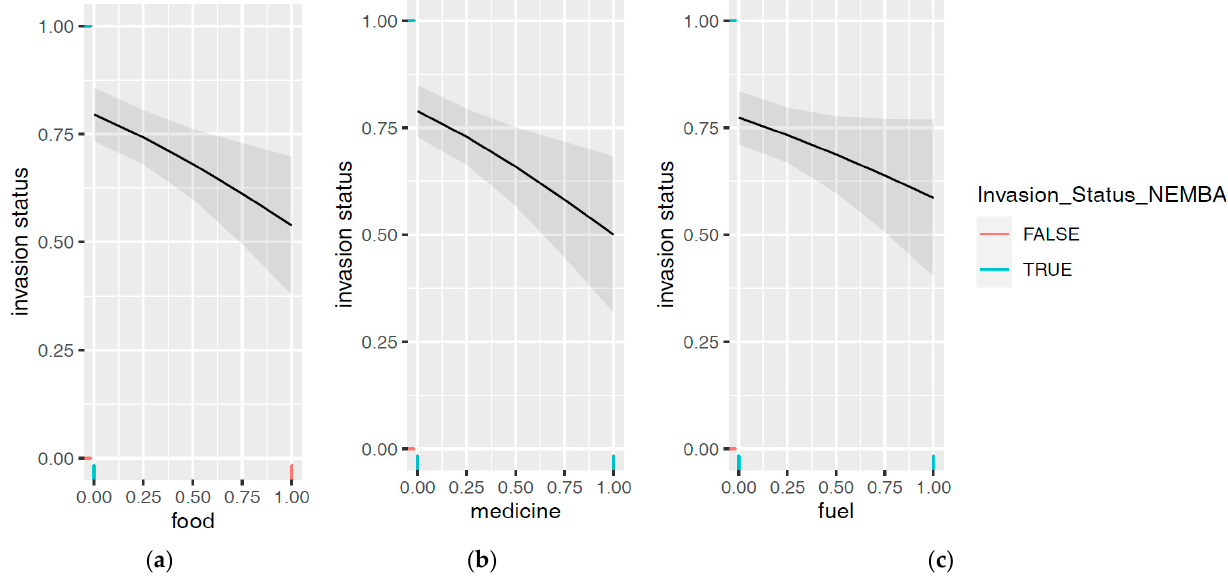
Figure 2. Relationships between invasion status and each service category. Only the three services that show significant correlation with invasion status are presented, which are as follows: ( a ) food, ( b ) medicine, ( c ) fuel. Invasion status is coded as follows: 0 (non-invasive) and 1 (invasive). The following are for service ‘food’: 0 (a species is not used as food) and 1 (the species is used as food). Same for medicine and fuel.